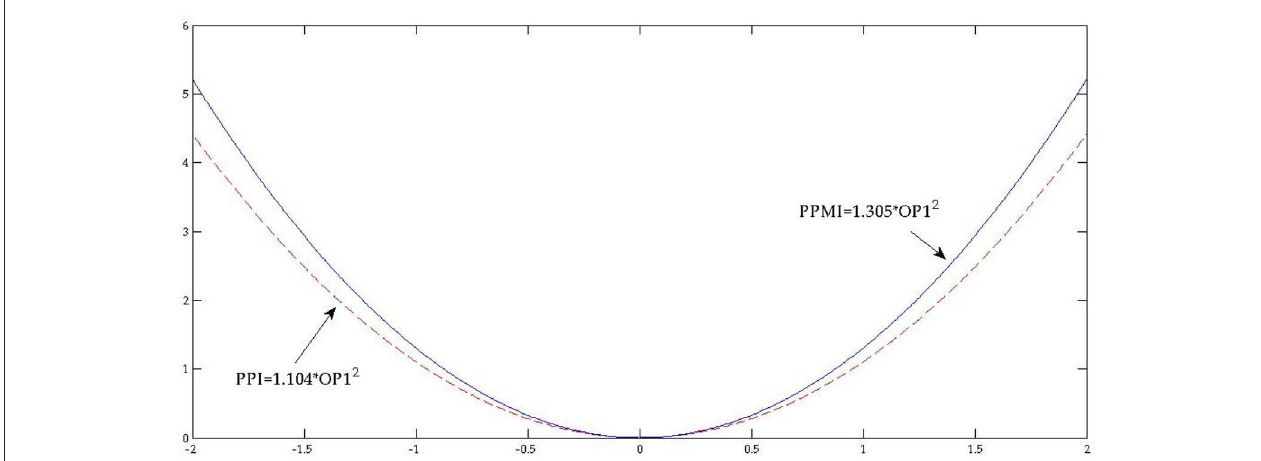
FIGURE 5 | Snapshot of the non-linear pass-through of the Brent oil price. For simplicity, we have omitted the other variables in Equation (6) and only report the non-linear term; thus, there is no effect of Brent oil price on consumer prices for both the PPI and MPPI when they are located at the coordinates